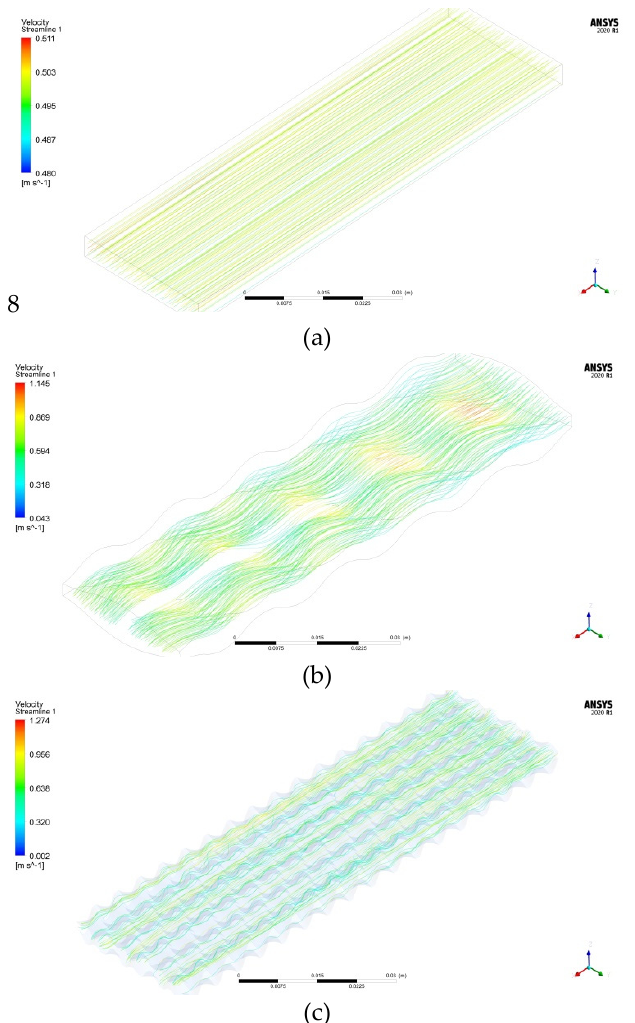
Figure 8. Particle trajectory: ( a ) flat heat exchange plate; ( b ) chevron heat exchange plate; ( c ) plate with conical stampings.